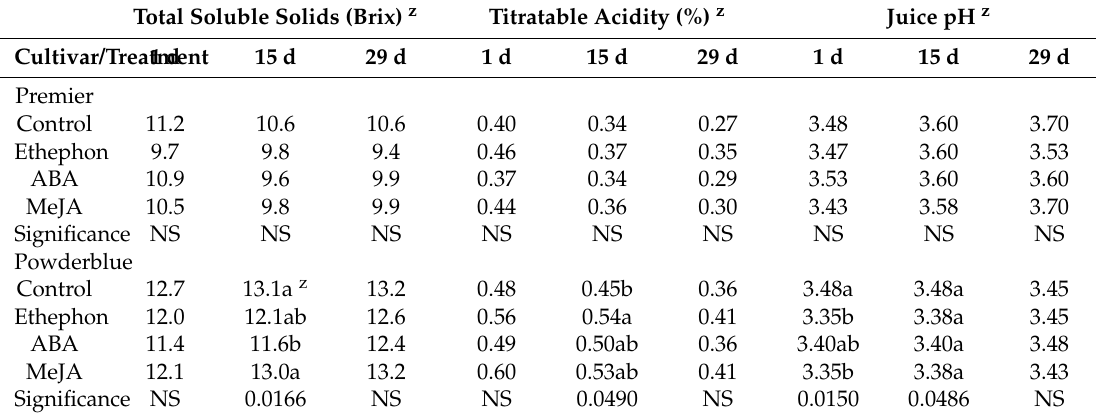
Table 4. Effect of preharvest treatment with water (control), ethephon, abscisic acid (ABA), and methyl jasmonate (MeJA) on fruit quality sampled after 1, 15, and 29 days of cold storage at 4 °C in Premier and Powderblue blueberry.